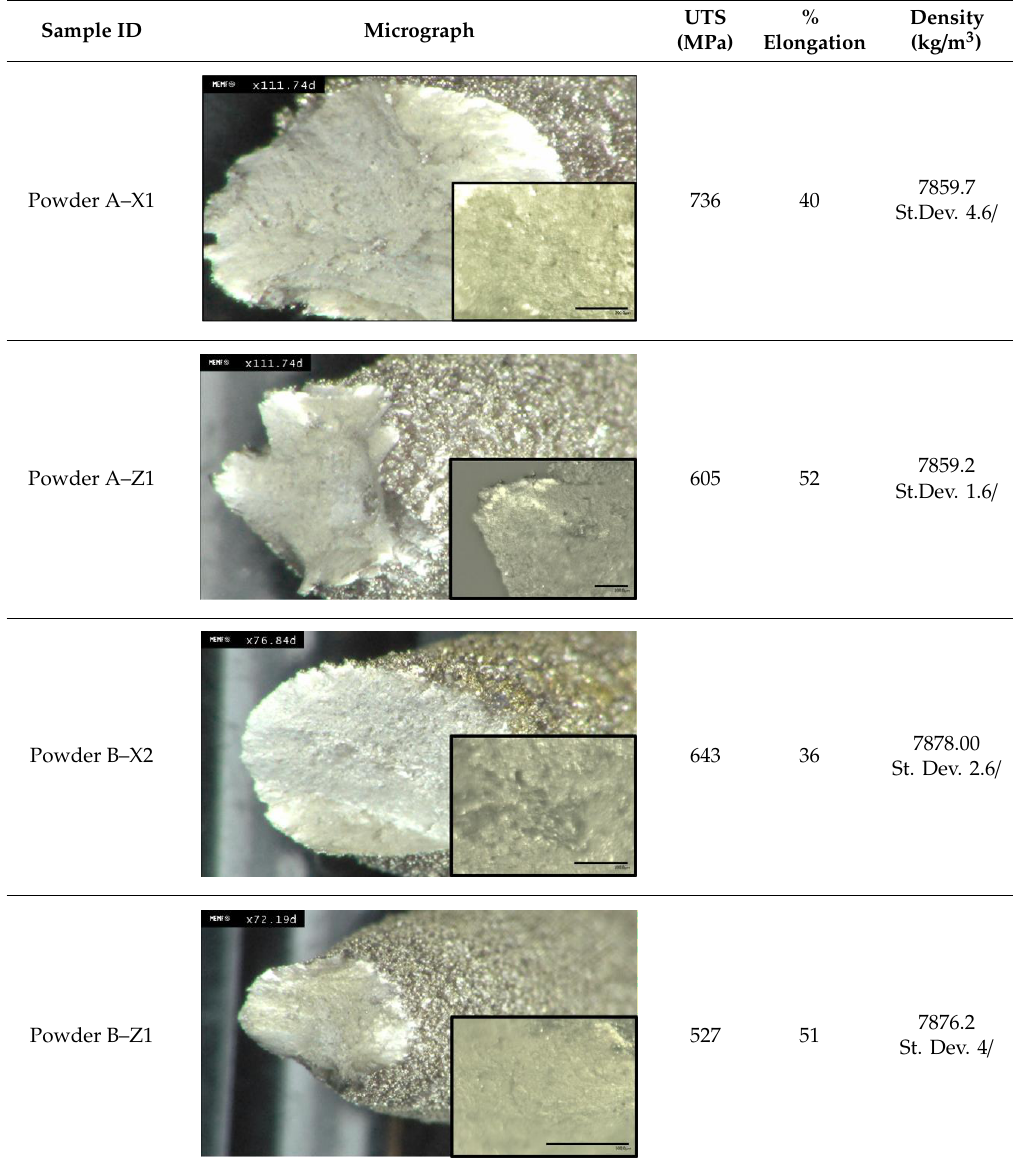
15 of 20 Figure 14. Illustration of micro-sections of cube printed with Powder B. Scale bars are (X) 400 μm, (Y) and (Z) 200 μm. X, Y and Z refer to the faces of the cube in relation to the melt pool (Z). 3.7. Fractography of Additively Manufactured Parts In order to examine the effect of process and feedstock parameters on the mechanical properties, the fracture surfaces were imaged and compared with the recorded tensile results and porosity values. A similar approach has been used by Bidulský et al. [46] and Casati et al. [47] using electron microscopy. Table 8 shows the images and tensile values for the samples produced from powder A and B, measured in both the X and Z directions. The X and Y orientation samples exhibited a shear break with higher UTS values, while the Z orientation had a more complex macroscopic fracture morphology, more necking and fracture lip formation. It can be noted on a visual inspection of the samples, that all exhibited some degree of ductility with the larger degree of necking and lip formation on the Z produced samples relating to their recorded lower levels of UTS and higher levels of ductility. Inset images of the fracture surfaces under higher magnification (300–500 ×) are also shown in